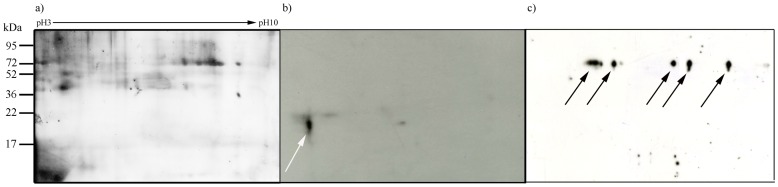
Western-blot analysis of BF2c extract.Proteins from BF2c extract were fractionated by two-dimensional gel electrophoresis on pH gradient-dried strips (pH 3–10). Replica gels were stained by silver-staining (a), electrotransferred to Immobilon-P membranes and then incubated with the PfuDPS antibody (anti-Pyrococcus furiosus DPS-protein) (b) or the IVI11C1 antibody (anti-Geobacter sulfurreducens cell extract) (c). Protein spots recognized by the PfuDPS or the IVI11C1 antibodies are marked by arrows.